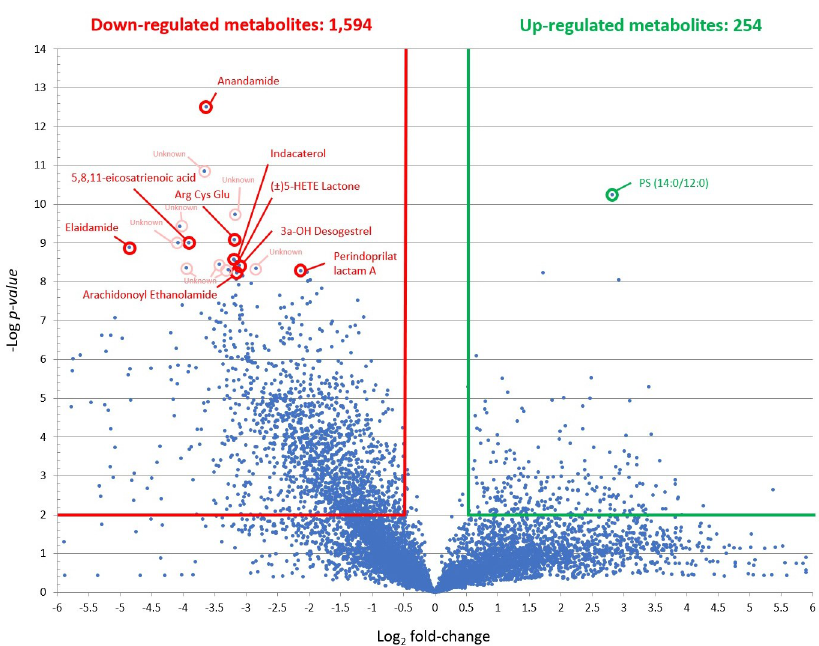
Fig 3. Volcano plots showing differentially expressed metabolites of S . mekongi following medium-dose PZQ treatment. Horizontal green and red lines represent p- values equal to 0.01. Vertical green and red lines represent fold changes equal to 1.5 and − 1.5, respectively. Top 10 metabolites with the lowest p -values (highly significant) and largest fold changes of each dose were labeled. Green and red refer to higher and lower abundance of metabolites, respectively.